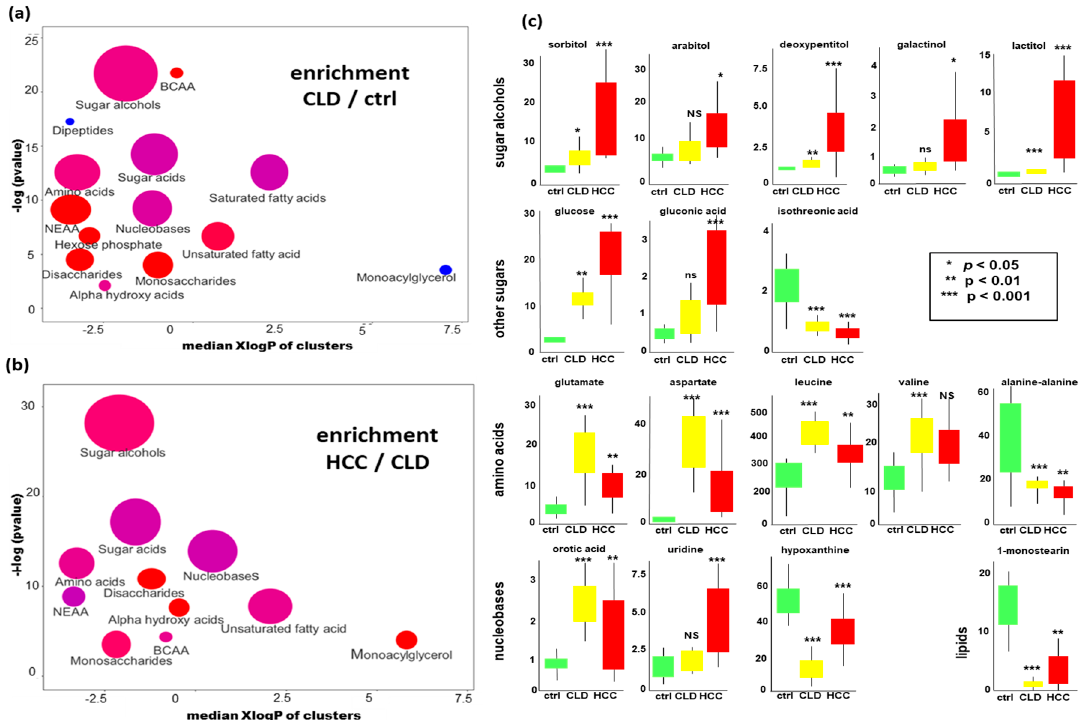
Figure 2. Significant differences in blood metabolites in HCC versus CLD patients and healthy controls. ( a ) Chemical set enrichment statistics (ChemRICH) comparing CLD to healthy control